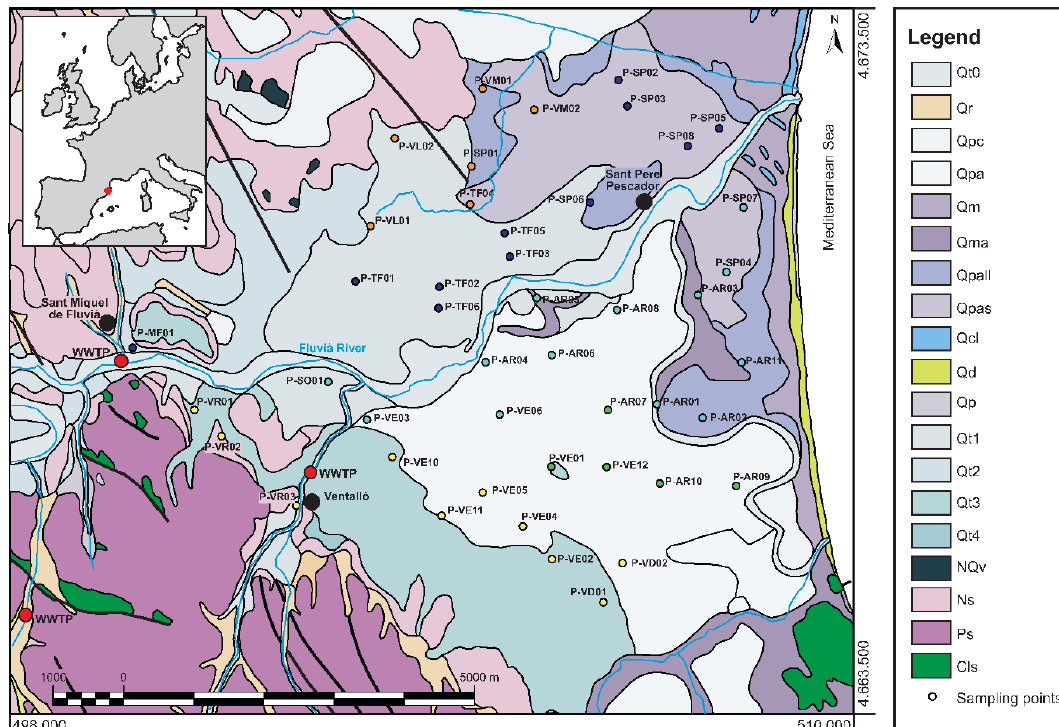
Figure 1. Geographical and geological scheme of the study area [14], and locations of groundwater sampling points. Legend: Qt0, current riverbed, floodplain, and fluvial terrace (0–2 m); Qr, current streambed deposits; Qpc, marsh silts and clays; Qpa, alluvial plain (gravels, sands, and clays); Qm, marsh areas (sands, silts, organic matter, and salts); Qma, abandoned meanders (gravels, sands, and silts); Qpall, deltaic plain (silts); Qpas, distributary channels in the deltaic plain (gravels and sands); Qcl, old coastal strip (sands with organic matter); Qd, coastal dunes; Qp, beach sediments; Qt1, Fluvià River terrace 1 (2–3 m above the stream level); Qt2, Fluvià river terrace 2 (10–15 m); Qt3, Fluvià River terrace 3; Qt4, Fluvià River terrace 4 (60–65 m); NQv, Neogene and Quaternary volcanic materials; Ns, Neogene sediments; Cls, Cretaceous limestones; blue lines represent rivers, red dots represent wastewater treatment plants, and black dots represent the main villages. Sampling points legend: zone 1A (alluvial plain left bank), dark blue; zone 1B (alluvial plain right bank), light blue; zone 2A (terraces 3 and 4 left bank), orange; zone 2B (terraces 3 and 4 right bank), yellow; zone 3 (points with a hydrochemical composition associated to the underlying Cretaceous limestone formations), green.